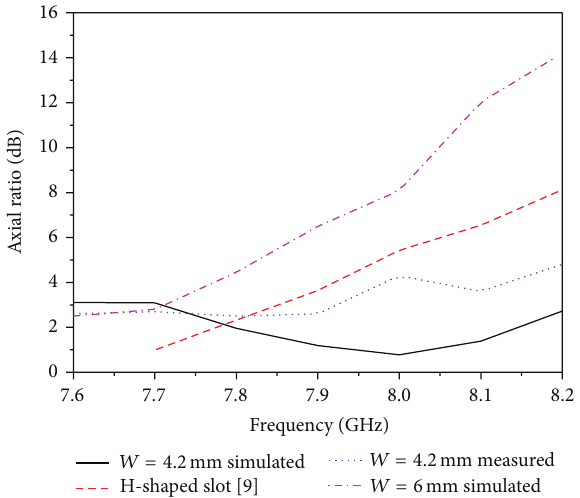
Figure 12: Radiation patterns of the SIW leaky-wave antennas fed from right side.